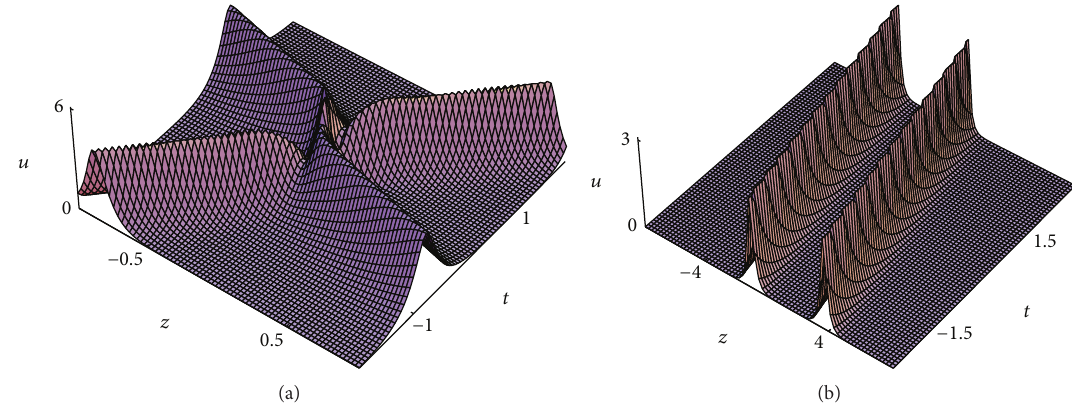
Figure 1: Evolution of the two-soliton solutions of (1). Parameters are (a) 𝜆 1 = 2 + 2𝑖 , 𝜆 2 = 3 + 2𝑖 , 𝛿 = 2.5 , Γ = 0.1 and (b) 𝜆 1 = 1 + 2𝑖 , = 1.0001 − 2𝑖 , 𝛿 = 2.5 , Γ = 0.1 . 𝜆 2